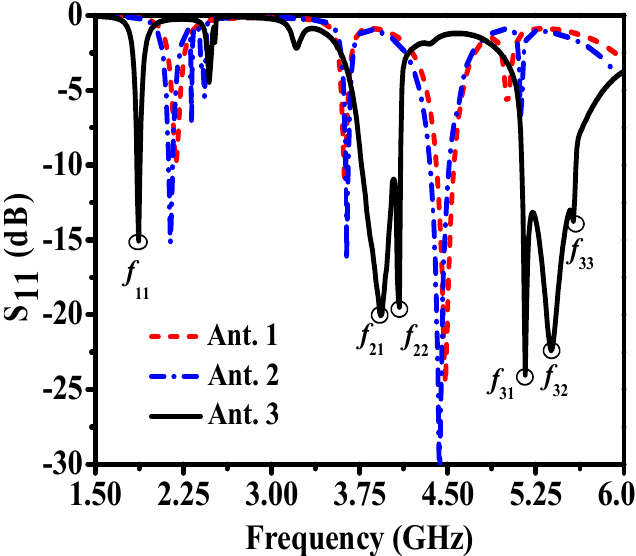
Figure 4. Comparison of simulated S 11 for the three antennas.